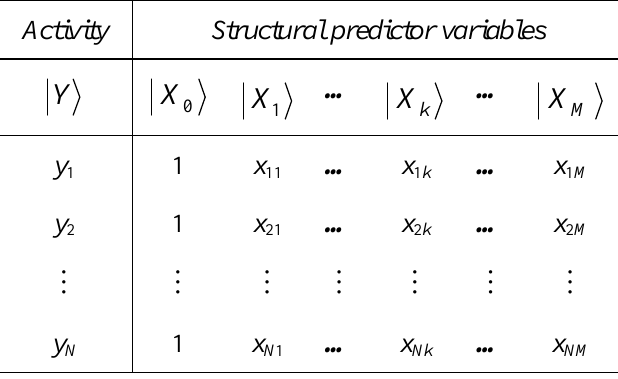
Table 2. The spectral (vectorial) version of SAR descriptors of Table